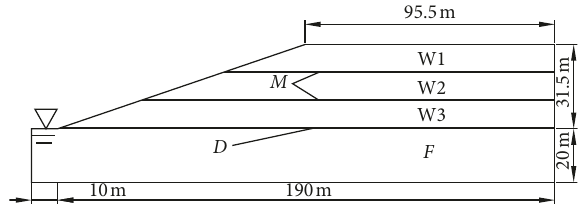
Figure 5: Calculation sketch of the model.